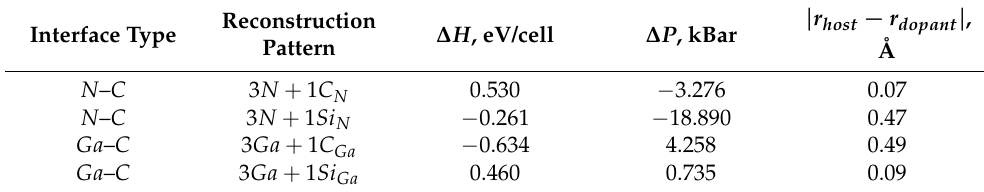
Table 4. Energy gain due to reconstruction in the topmost GaN substrate’s